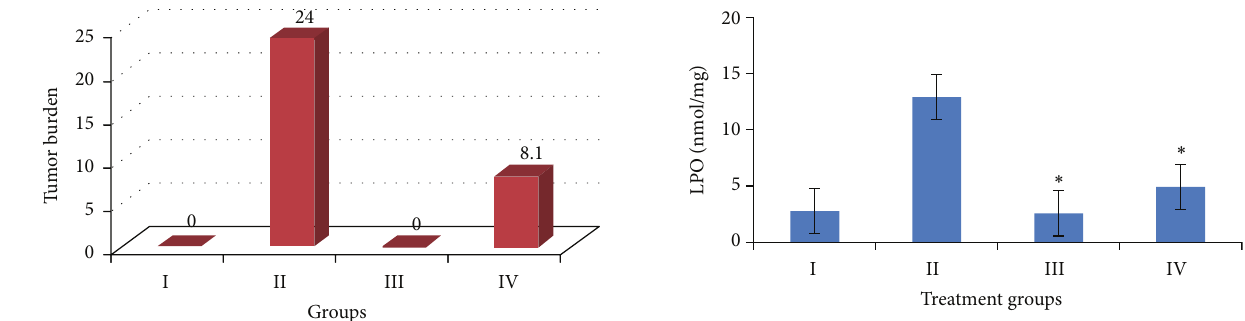
Figure 2: Variations in tumor burden in DENA/CCl 4 induced hepatic carcinogenesis with/without ACE administration.